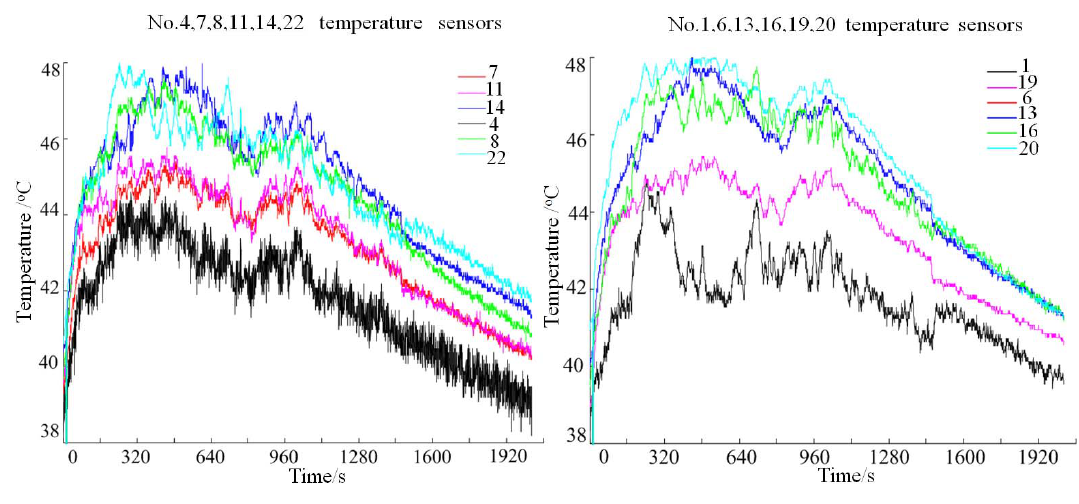
Figure 19. Temperature measurement in the urban traffic jam